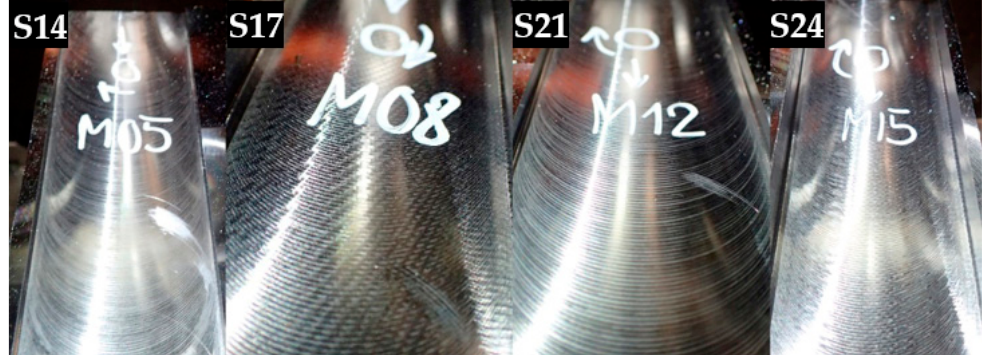
Figure 11. Surfaces from Experiment 3. The measurements S14 and S21 were identified as stable according to the surface, S17 and S24 as chatter.